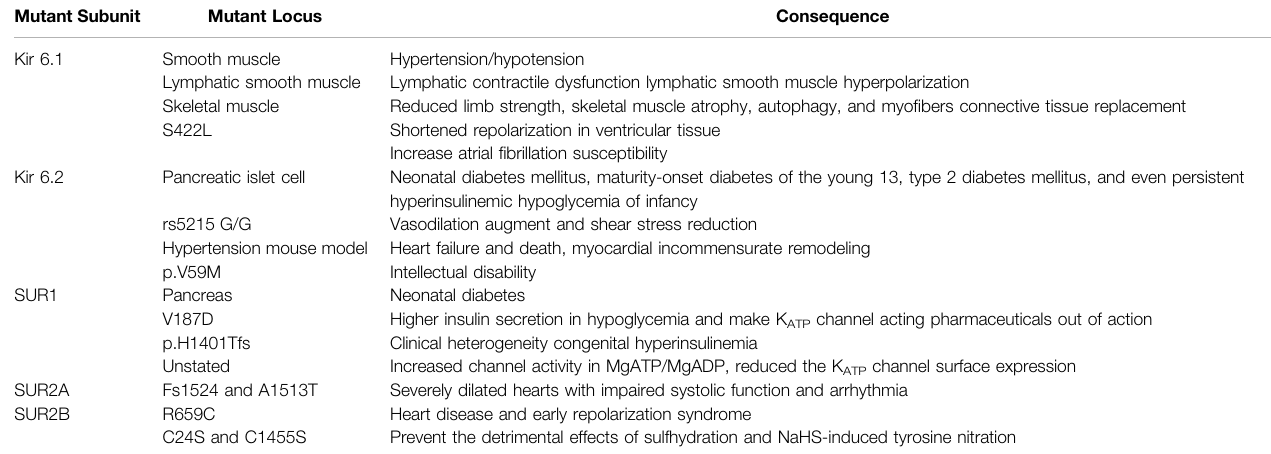
TABLE 2 | Monosubunit mutation and their locus and consequence. Mutant Subunit Mutant